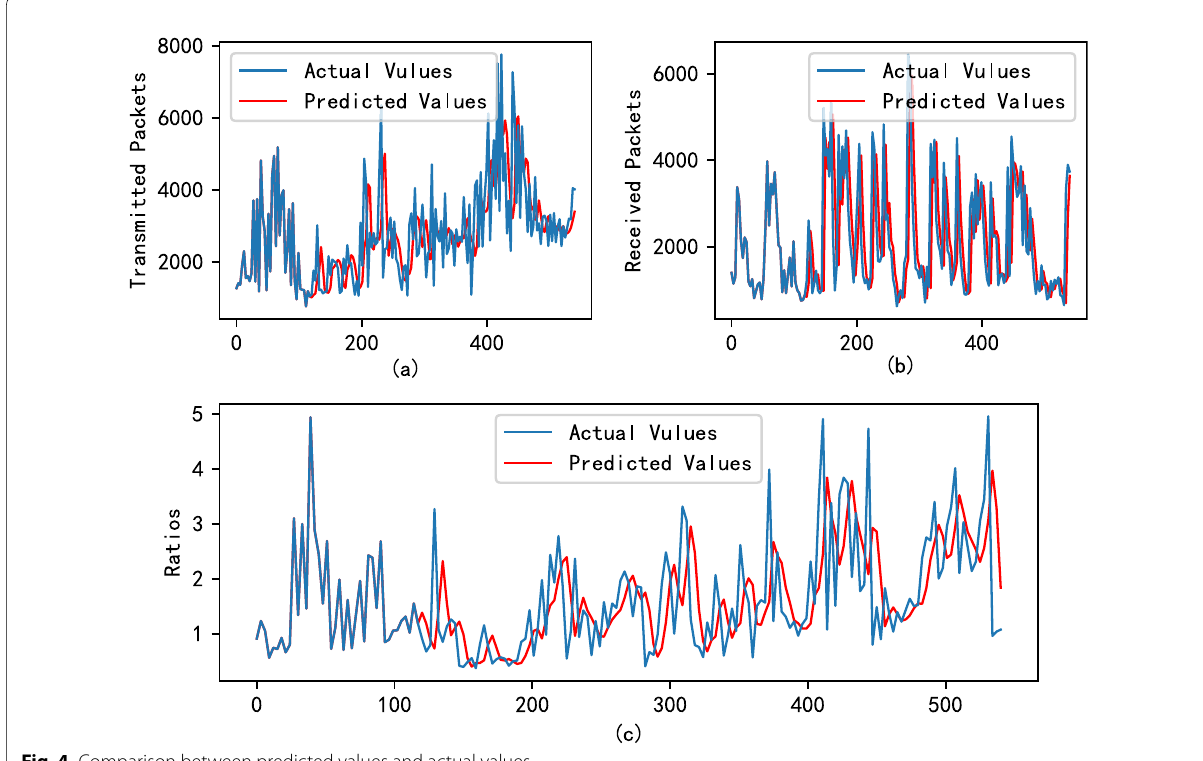
Fig. 4 Comparison between predicted values and actual